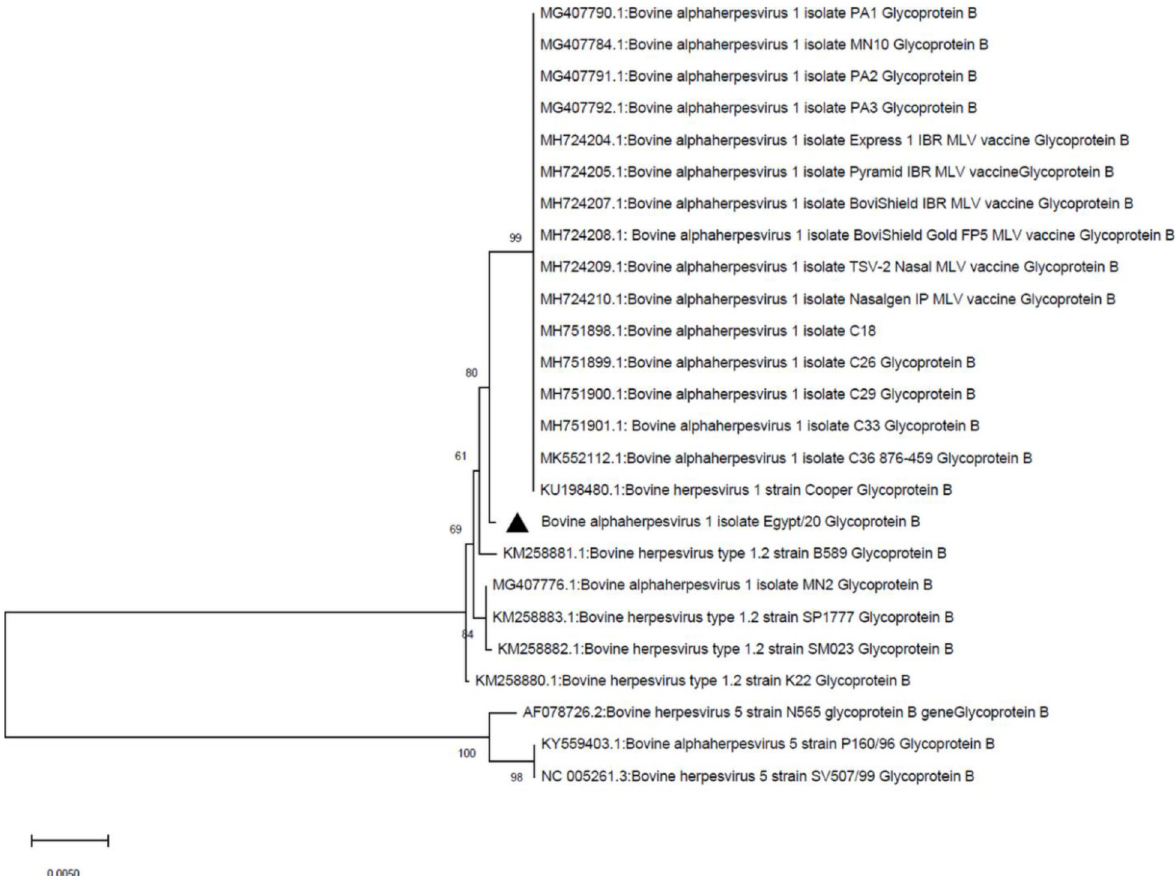
Fig 2. Phylogenetic analysis of BHV-1 gB. The evolutionary history was inferred using the neighbor-joining method [20]. The percentages of the replicate trees in which the associated taxa clustered together in the bootstrap test (1000 replicates) are shown next to the branches [21]. The evolutionary distances were computed using the maximum composite likelihood method [22] and are shown as the number of base substitutions per site. The codon positions included were 1 st + 2 nd + 3 rd + Noncoding. Evolutionary analyses were conducted in MEGA X [19]. Different identical sequences were included to increase the robustness of the constructed